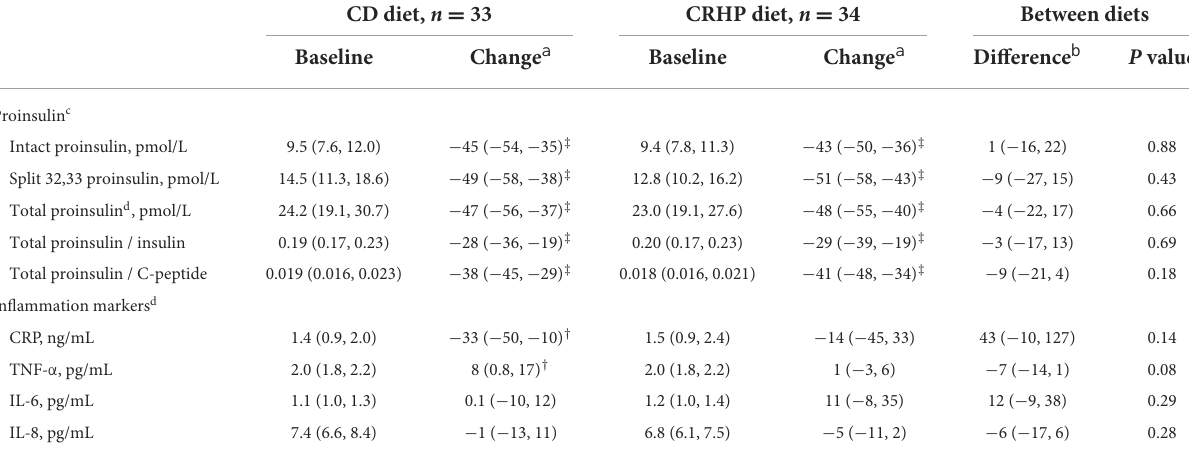
TABLE 4 Basal concentrations of proinsulin-like molecules and markers of inflammation at baseline and after matched ∼ 6% weight loss by a CD or a CRHP diet in individuals with T2D and overweight or obesity. CD diet, n = 33 CRHP diet, n = 34 Between diets Baseline Change a Baseline Change a Difference b P value Proinsulin